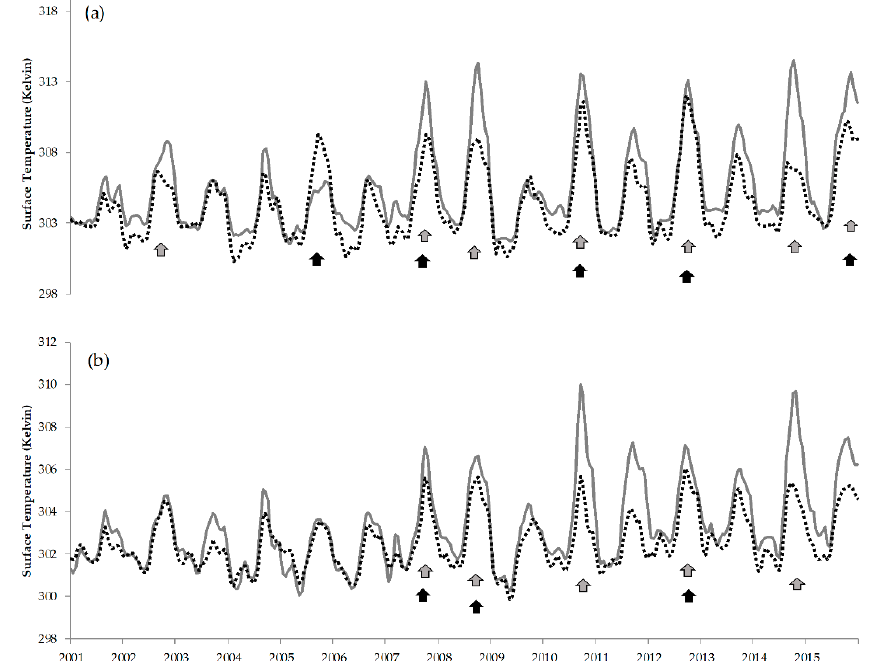
Figure 13. Time series of Land Surface Temperature in the Araguaia National Park and Cantão State Park, considering: ( a ) Altered Forested Savanna, with five (dotted line) and seven (gray line) years of fire; and ( b ) Grassy-woody Savanna, with three (dotted line) and five (gray line) years of fire. Arrows indicate the exact dates of fires in these pixels, black arrow for dotted line and gray arrows for the gray line.